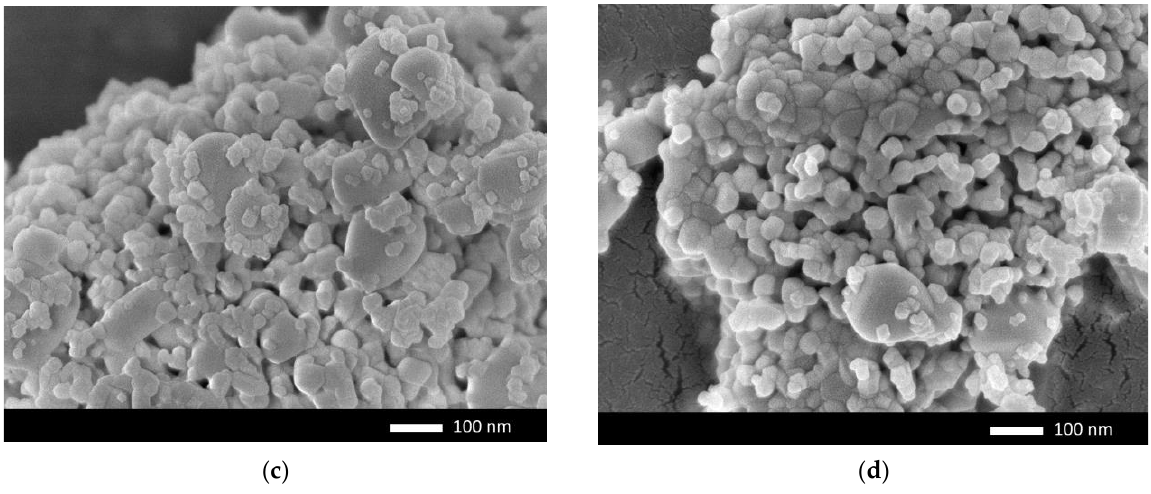
Figure 1. Results of morphological studies of synthesized ZrO 2 – CeO 2 ceramics depending on the Y 2 O 3 dopant concentration: ( a ) Pristine sample; ( b ) 5%; ( c ) 10%; ( d ) 15%.